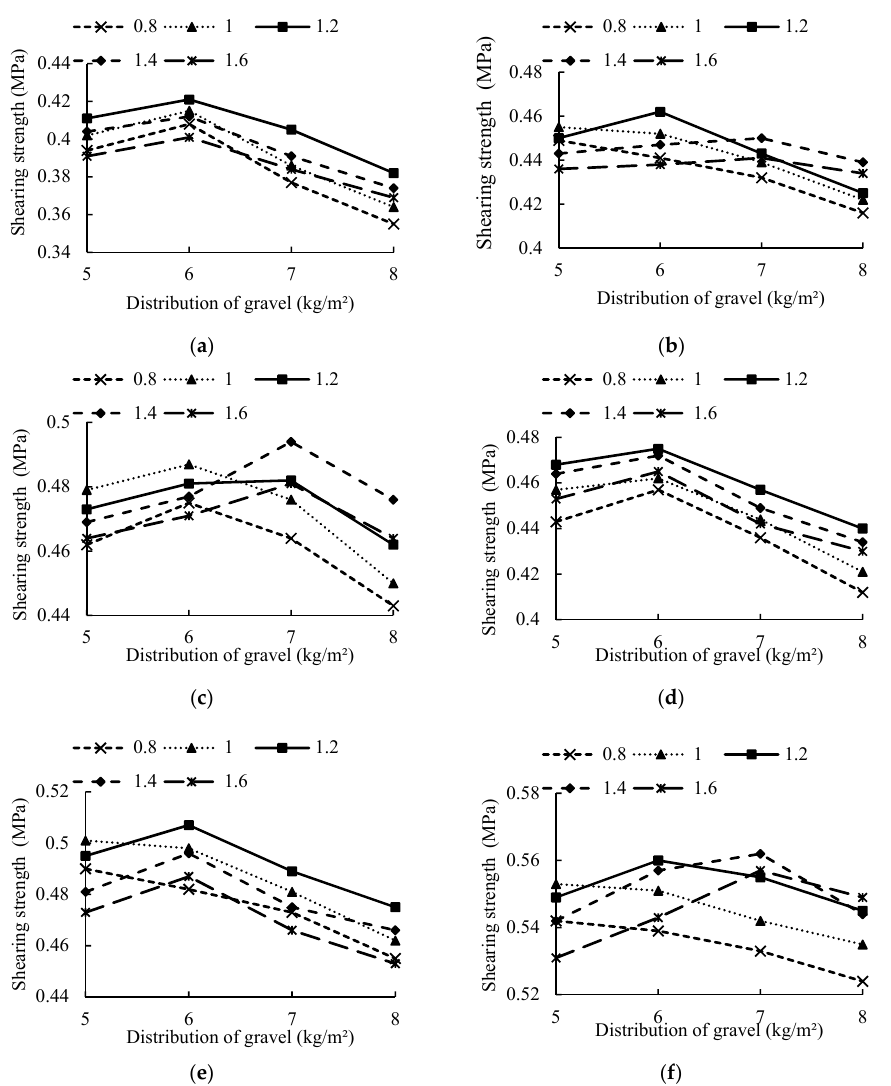
Figure 2. Shear strength of SBS-modified emulsified asphalt with different spreading and disposal schemes: ( a ) Emu-A-brushed; ( b ) Emu-A-grooved; ( c ) Emu-A-exposed; ( d ) Emu-B-brushed; ( e ) Emu-B-grooved; ( f ) Emu-B-exposed.